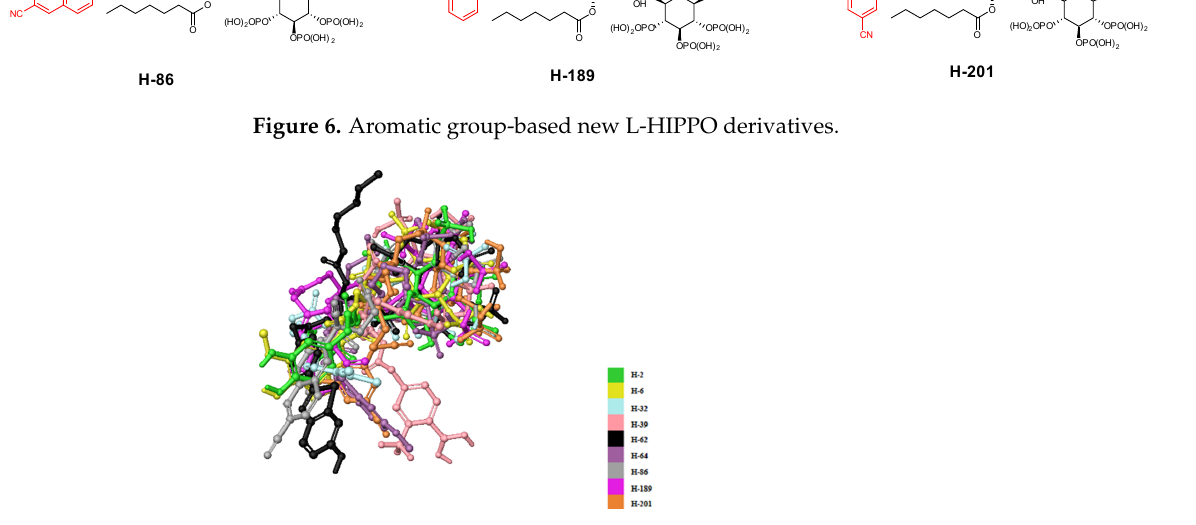
Figure 7. Alignment of nine new L ‐ HIPPO derivatives (H ‐ 2, H ‐ 6, H ‐ 32, H ‐ 39, H ‐ 62, H ‐ 64, H ‐ 86, H ‐ 189, and H ‐ 201) in the MA domain (PDB ID: 7E1I).